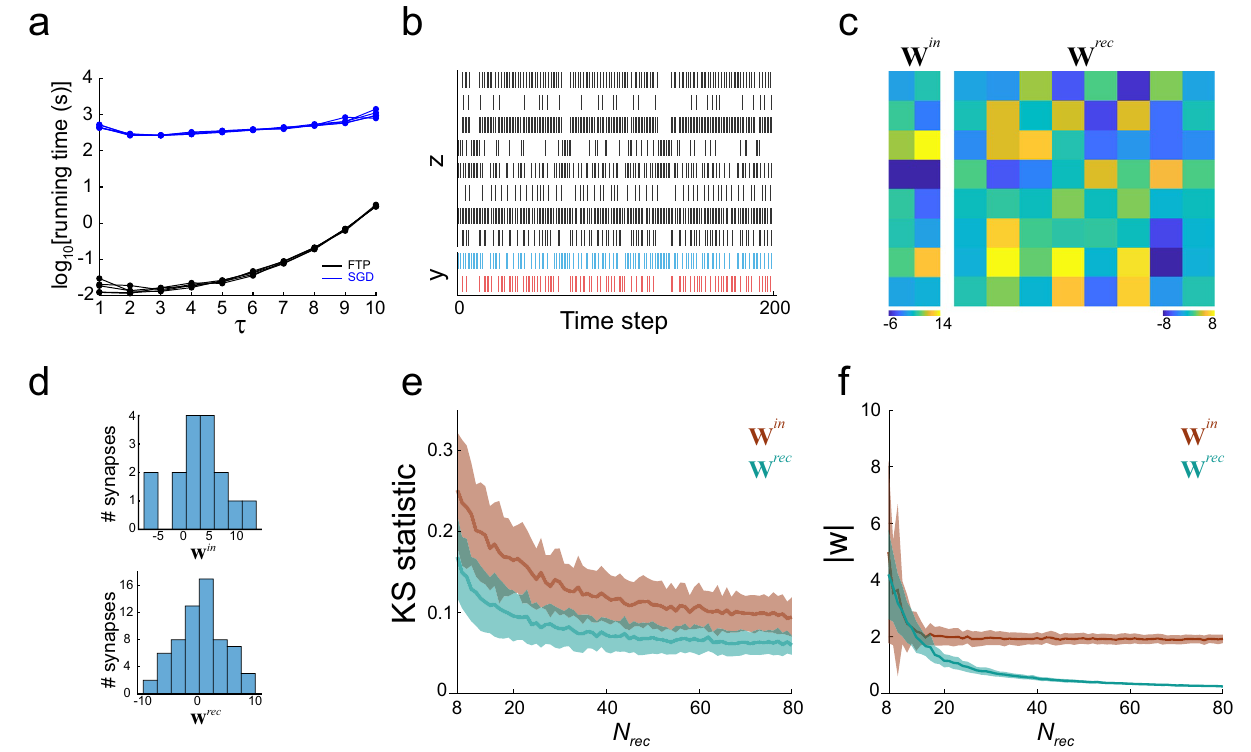
Figure 2. Solving the s-task with the FTP algorithm. ( a ) Efficiency of FTP and SGD, measured as the time expended in finding a solution network for s-tasks of different τ . The time expended by the FTP algorithm is orders of magnitude lower than the time expended by the SGD algorithm (n = 5 networks for each τ value). ( b ) Raster plot showing the neurons firing states in a network constructed to solve the s-task for τ = 3 . The network is composed of 8 integration neurons and 2 input neurons. Each possible sequence of 3 stimuli has a unique network firing state that codifies the sequence. Therefore, the network has 8 possible firing states. ( c ) Input and recurrent synaptic weights of the network. ( d ) Distribution of synaptic weights for input (upper panel) and recurrent (lower panel) synaptic weights, for the same network as in ( b,c ). ( e ) Kolmogorov–Smirnov statistic between the distribution of synaptic weights and a normal distribution of the same mean and variance. As the network size increases, the distribution of synaptic weights gets closer to a normal. Integration neurons weights are closer to a normal distribution than sensory neurons weights. Mean ± SD are shown for n = 100 networks that solve the s-task, with τ = 3 . ( f ) Absolute synaptic weight values as a function of network size. Absolute values are higher and of larger variability when the neuron count is close to the number of coded stimuli sequences. As the network size increases the absolute mean value and dispersion decrease. Input neurons weights quickly reach a minimum, while integration neurons weights decrease in the entire range of network sizes. Mean ± SD are shown for n = 100 networks that solve the s-task, with τ = 3